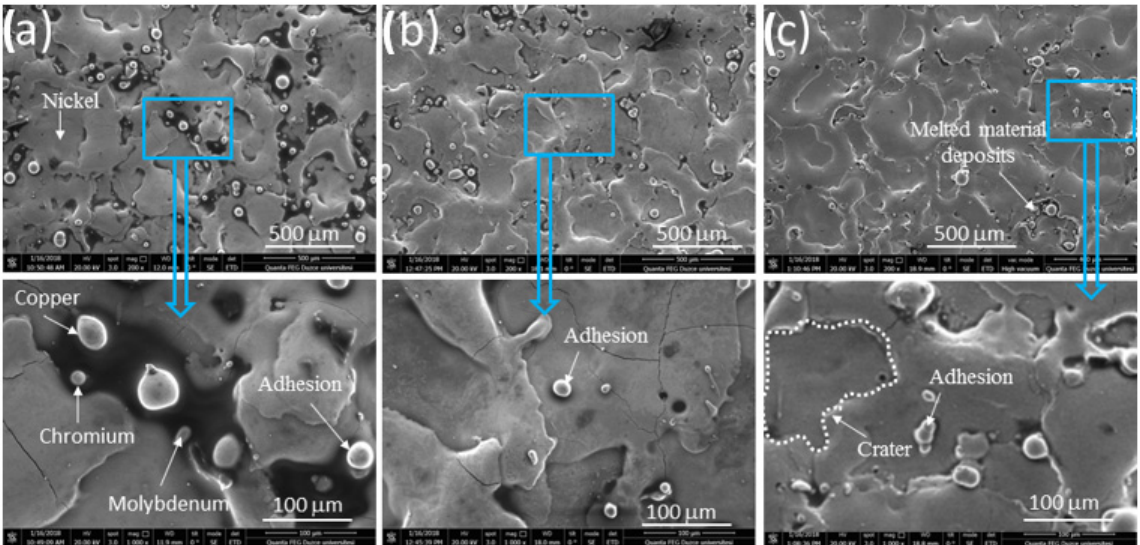
Figure 8. SEM images of samples: ( a ) UT (1-7), ( b ) SCT (2-7) and ( c ) DCT (3-7). The SEM images of the materials with the highest average surface roughness are shown in Figure 9. During the first electron discharge of the electrode, particles melted from the material surface flow to the sample surface, forming a thin layer. The highest average surface roughness in the UT, SCT and DCT samples was generated at a peak cur- rent of 10 A. The width of the thin layers formed on the surface is almost the same in all samples. More spherical particles seemed to adhere in the UT and DCT samples. Figure 9. Cross-section views of samples: ( a ) UT (1-7), ( b ) SCT (2-7) and ( c ) DCT (3-7). 3.3. Analysis of the Signal-to-Noise (S/N) Ratio The interactions of the MRR and Ra results with the control factors were measured by carrying out the experimental design. Signal/noise (S/N) ratios were used in the opti- mization of the control factors. Table 7 shows estimates of the Ra and MRR and the S/N ratios. Estimated values were calculated with the module (fit model) using the program Minitab Normally, both MRR and electrode wear loss are calculated for the abrasion of materials, and the amount of wear is determined with respect to time. As a result of the experiments, the weight of the electrode materials was seen to increase. In this weight increase, chip particles melted from the material surface adhered to the surface of the elec- trode where it formed a thin film layer.